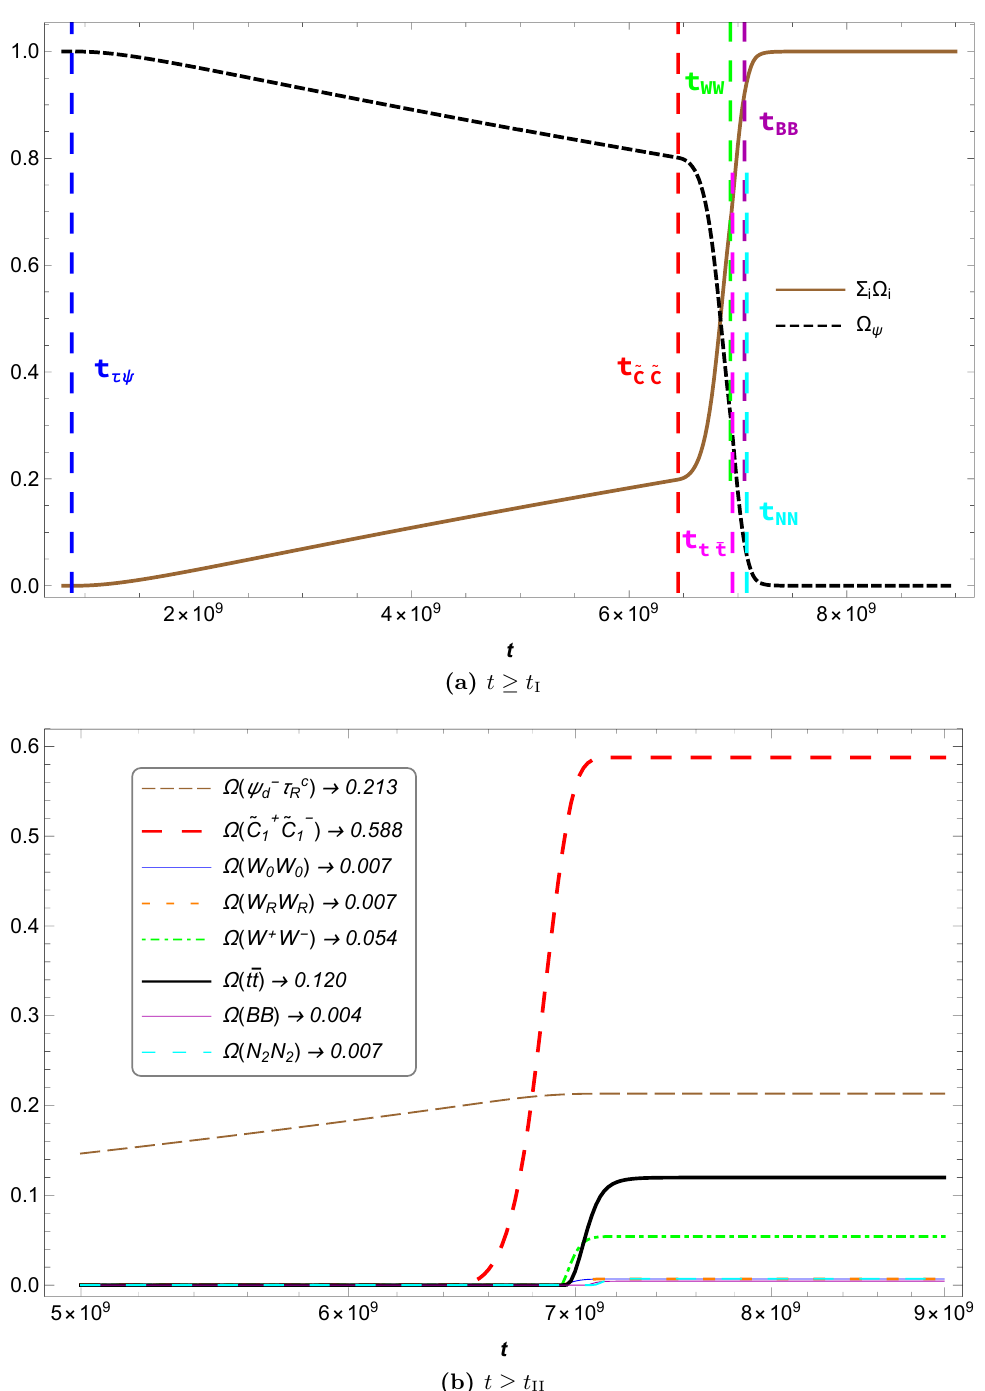
Figure 15. In (a), we plot the evolutions of (cid:10) and P of reheating. The time at which each specie is turned on is marked with a vertical line, where t (cid:28) (cid:3) = 8 : 78 (cid:2) 10 8 , t ~ = 6 : 45 (cid:2) 10 9 , t WW (cid:3) = 6 : 93 (cid:2) 10 9 , t C ~ C (cid:3) t NN (cid:3) = 7 : 08 (cid:2) 10 9 . In (b), we plot each (cid:10) i from t II to sometime after the end of reheating. Note that (cid:10)( (cid:0) (cid:28) c ) = 0 : 183 at t II R d